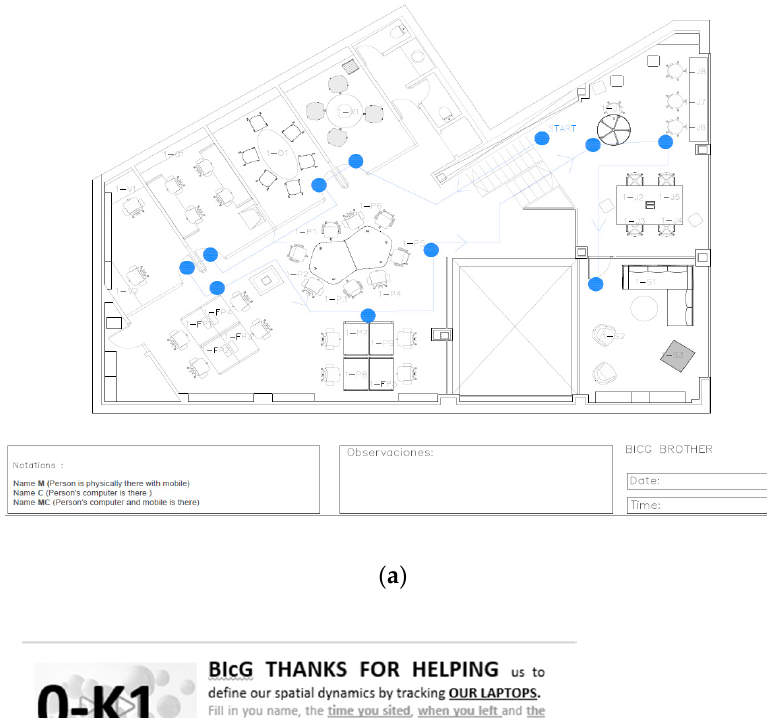
Figure 6. Example of workplace area layout tagged by DARs identified by colors. APs are also tagged and named. ( a ) Ground Floor (spaces: Workshop, Kitchen, Flower, Altar, Clients, and Re- ception); ( b ) First Floor (spaces: Jardín, Salon, Pradera, Video, Green, Orange, and Red); ( c ) Second Floor (spaces: Dungeons, Imperial, and Grey).